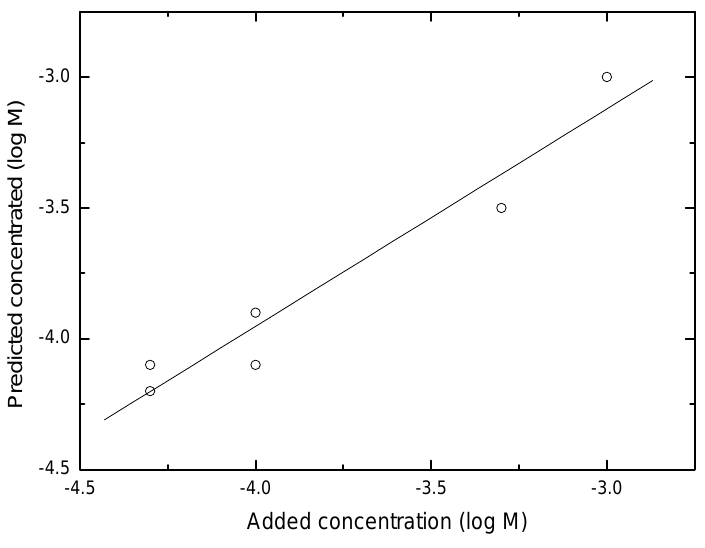
Figure 13. Calibration curve (18 samples) of n-butyrate in test mixtures of key odorants containing p- cresolate at pH 8. BPNN used 6, 9, 1